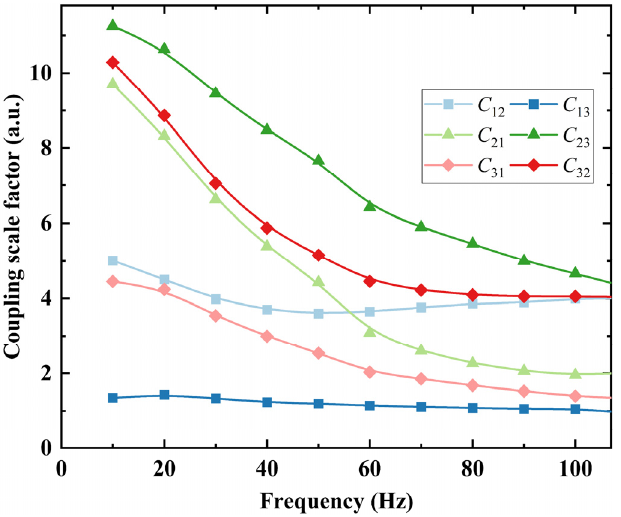
Figure 7. The coupling scale factors at different frequencies. The data was collected within the bandwidth of the atomic magnetometer.